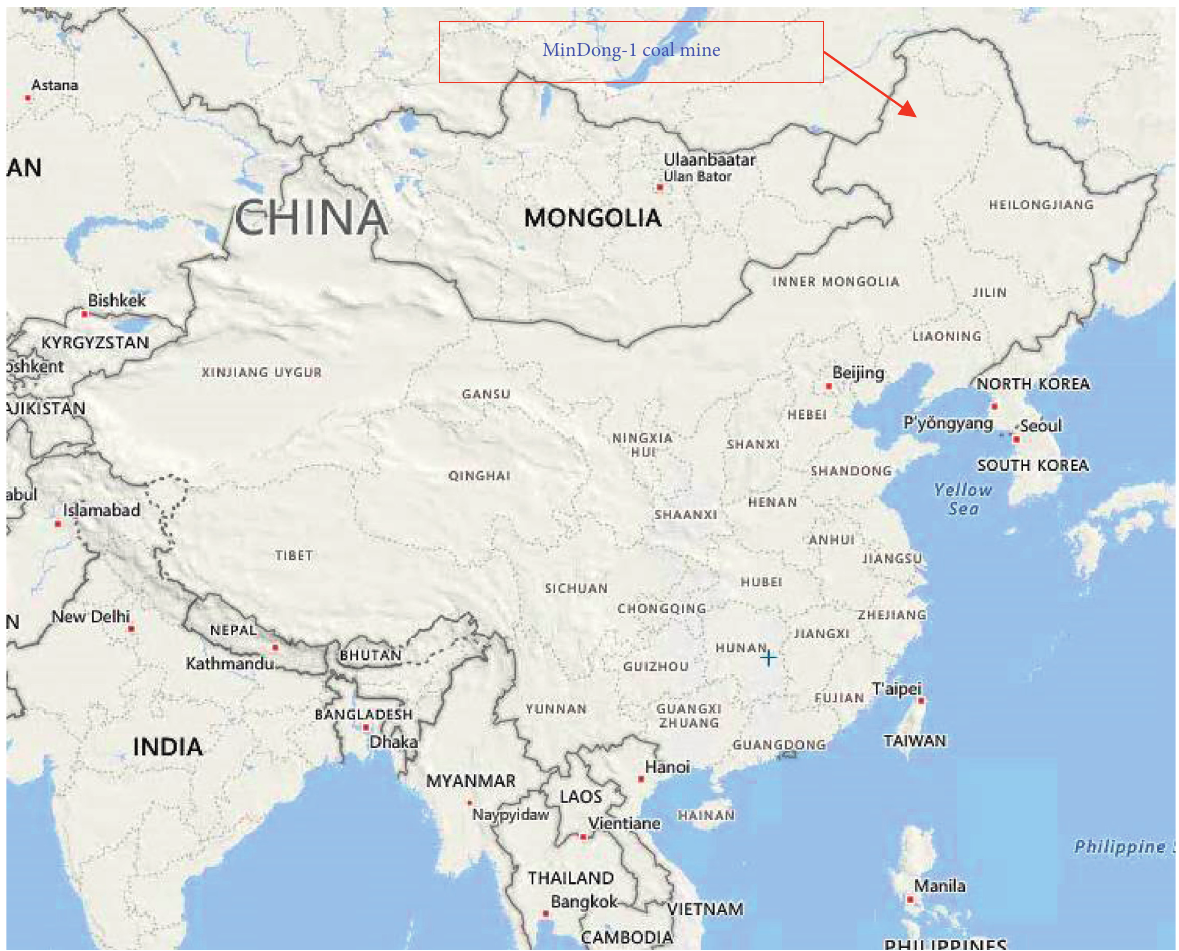
Figure 6: Location of MinDong-1 coal